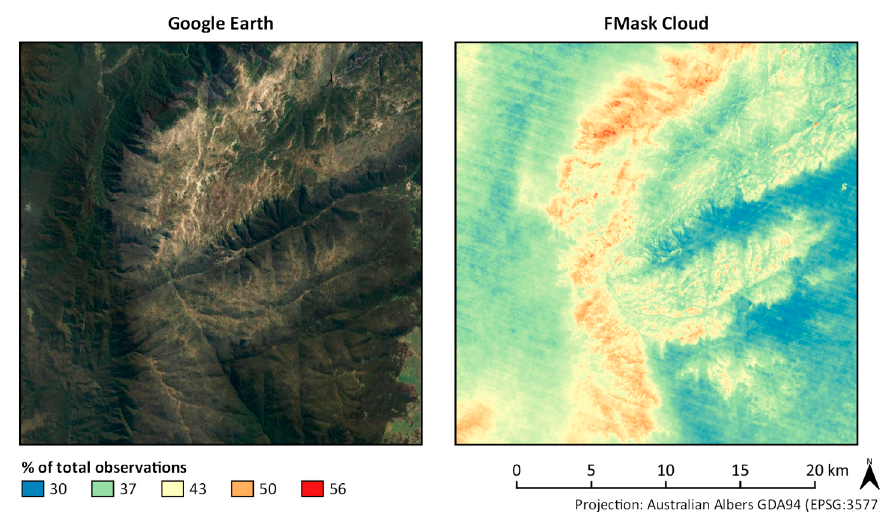
Figure 5. High-resolution imagery (Google, CNES/Airbus, DigitalGlobe) and number of observations flagged as cloud by Fmask in percent of total observations at Mt. Kosciuzsko, NSW.